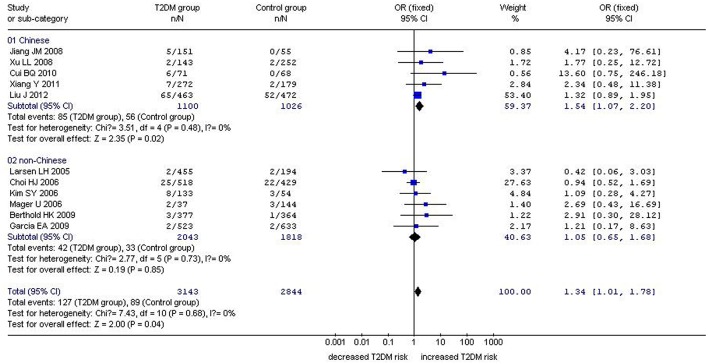
Forest plot of T2DM associated with GHRL gene Leu72Met (L72M) polymorphism under a homozygous genetic model (MM vs. LL). Under the homozygous genetic model, a significant correlation between the GHRL Leu72Met gene polymorphism and T2DM was found (OR: 1.34, 95% CI: 1.01–1.78, P = 0.04). A more pronounced correlation between them was found (OR: 1.54, 95% CI: 1.07–2.20, P = 0.02) in the Chinese population. No significant correlation was detected in the non-Chinese population (OR: 1.05, 95% CI: 0.65–1.68, P = 0.85).